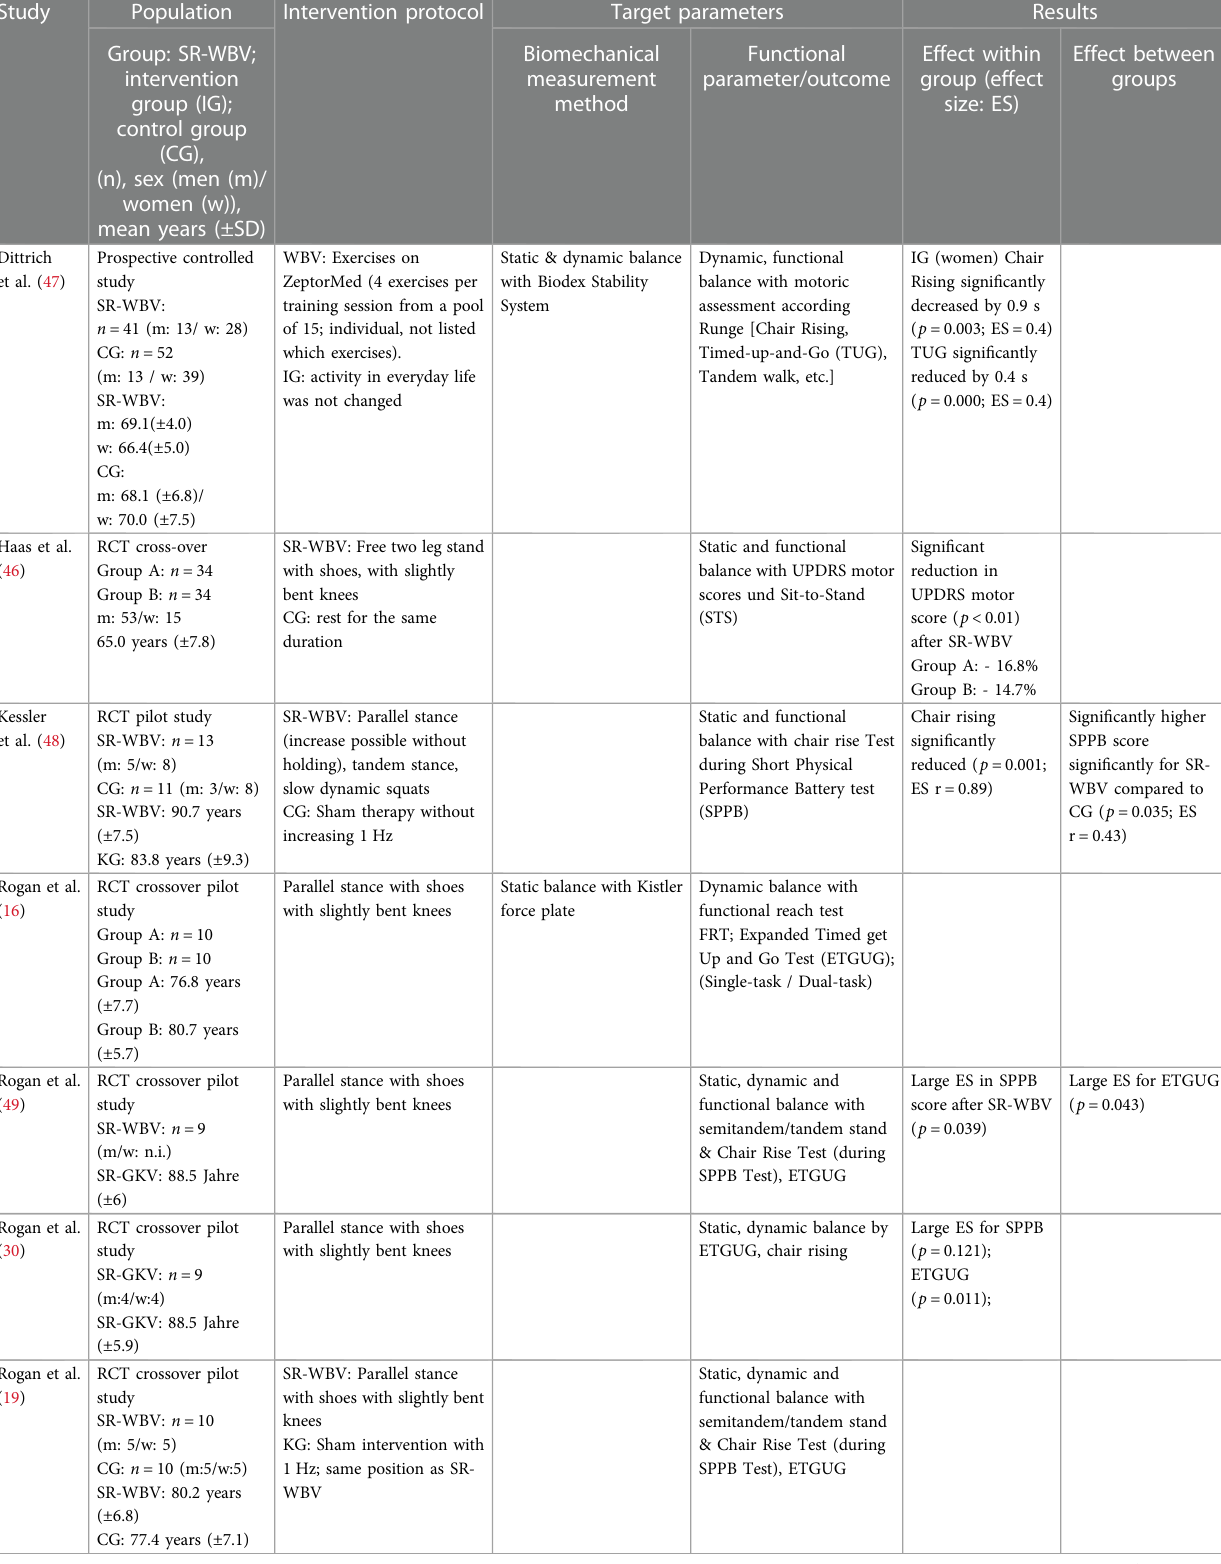
TABLE 1 Overview of the study characteristics of the included studies.